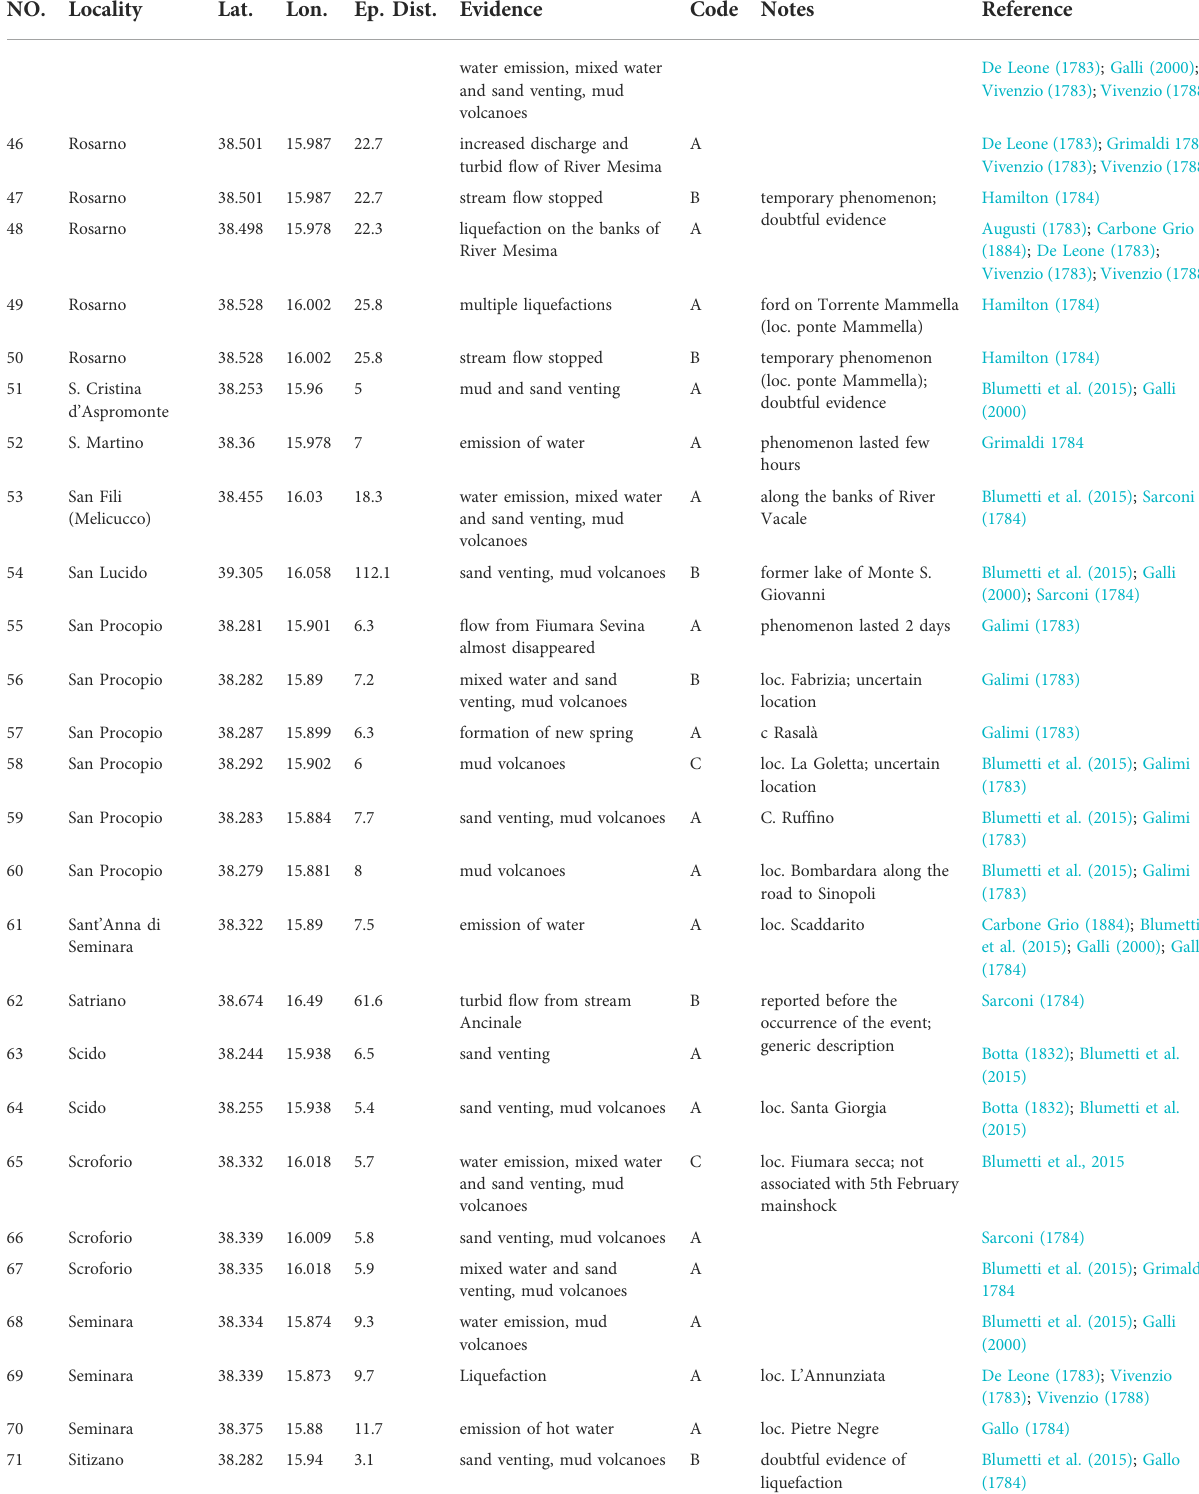
TABLE2( Continued )Listofthehydrologicaleffectsassociatedwiththe1783earthquake(progressive numbercorrespondstoFig.5).Theattributionof the quality code to the 78 effects is based on the reliability of the reference/account associated with the observation (see main text). The epicentral distance (in kilometers) is calculated from the location of the Italian seismic Catalogue (Rovida et al.,